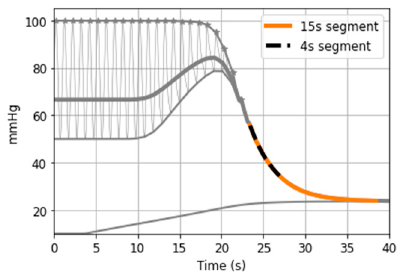
Figure 17. Feasibility of simulation-based time constant and P Equilibrium measurement.